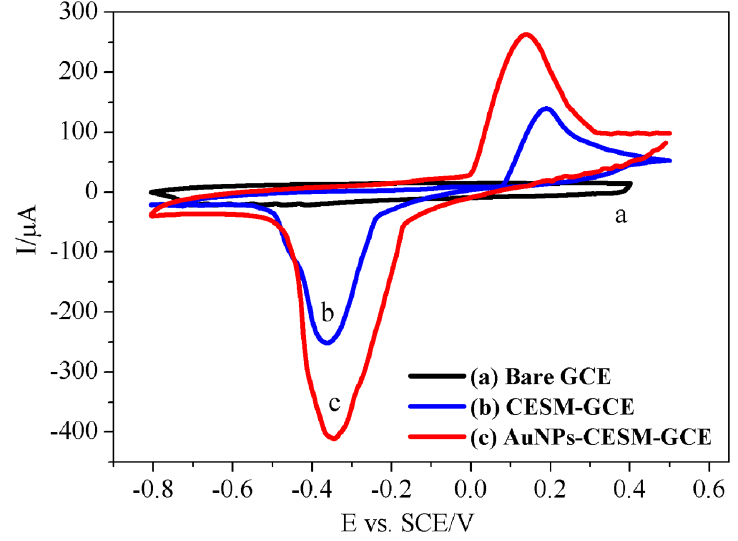
Fig 4. Cyclic voltammograms of modified electrodes. Bare GCE (a), CESM-GCE (b), AuNPs – CESM-GCE (c), in 0.1 M pH 7.0 PBS at a scan rate of 50